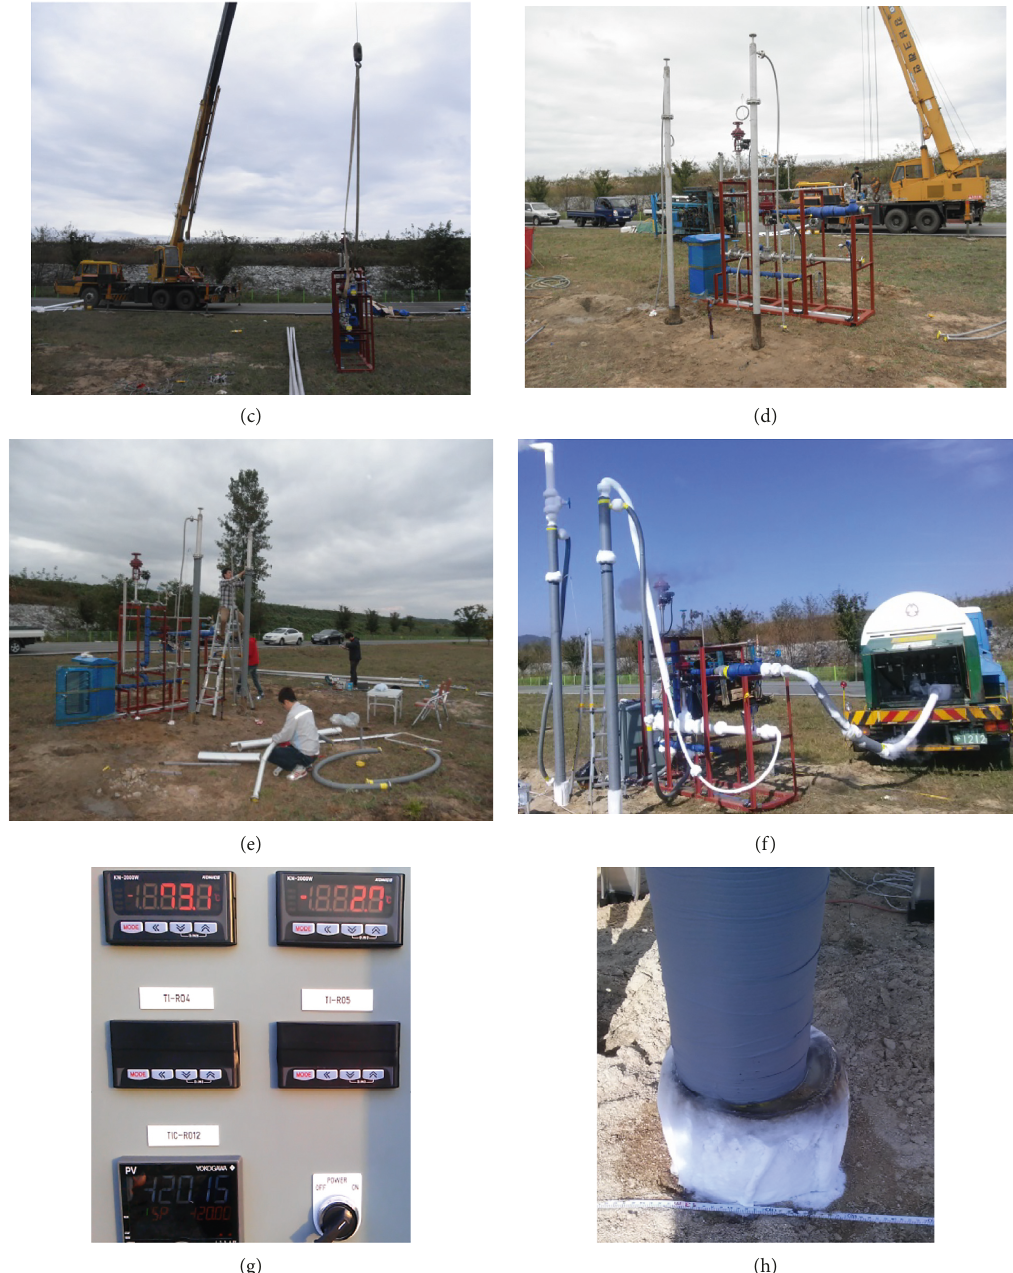
Figure 8: Ground freezing system installation procedure. (a) Freezing pipe insertion, (b) inserted freezing pipe, (c) installation of LN supply system, (d) LN 2 supply connected to freezing pipe, (e) pipe insulation, (f) LN 2 supply, (g) automated control panel, and (h) freezing pipe after LN 2